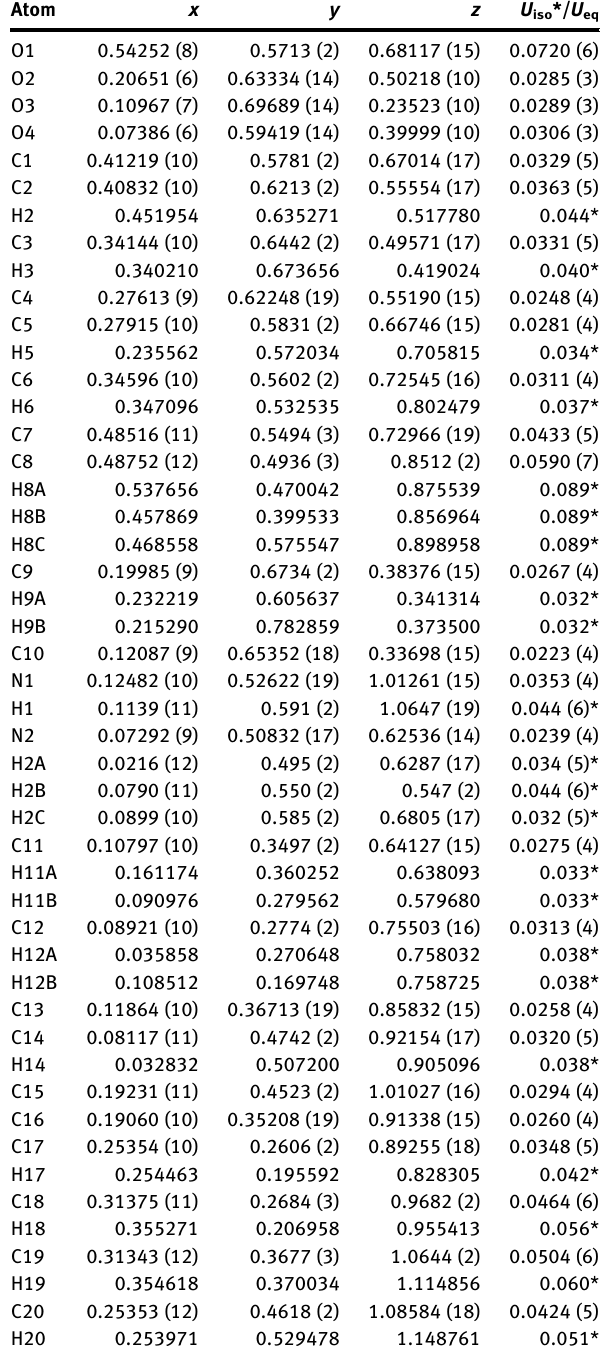
Table  : Fractional atomic coordinates and isotropic or equivalent isotropic displacement parameters (Å 